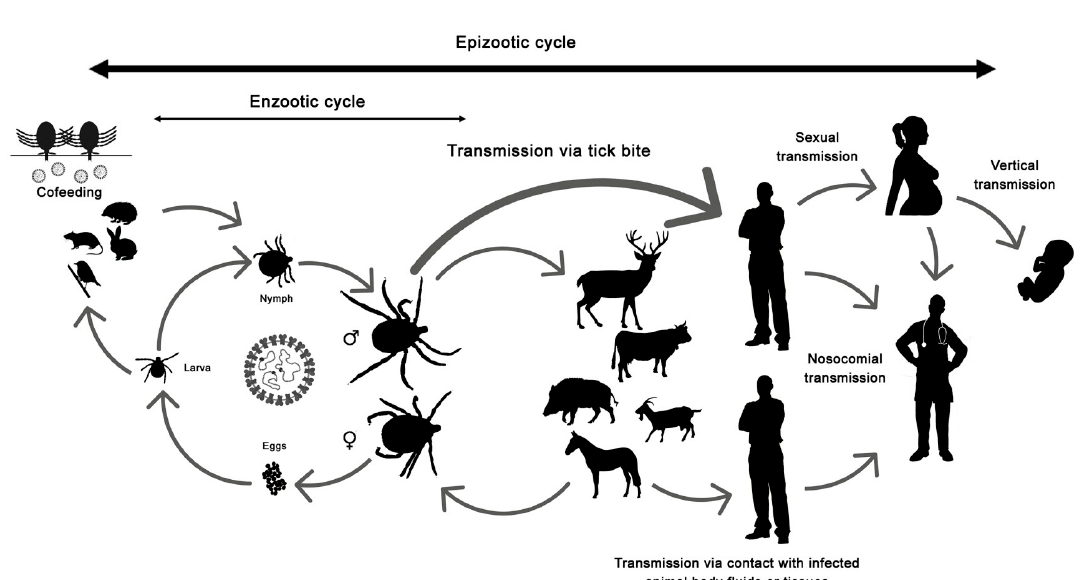
Figure 1. Crimean-Congo hemorrhagic fever virus (CCHFV) cycle and its routes of transmission.